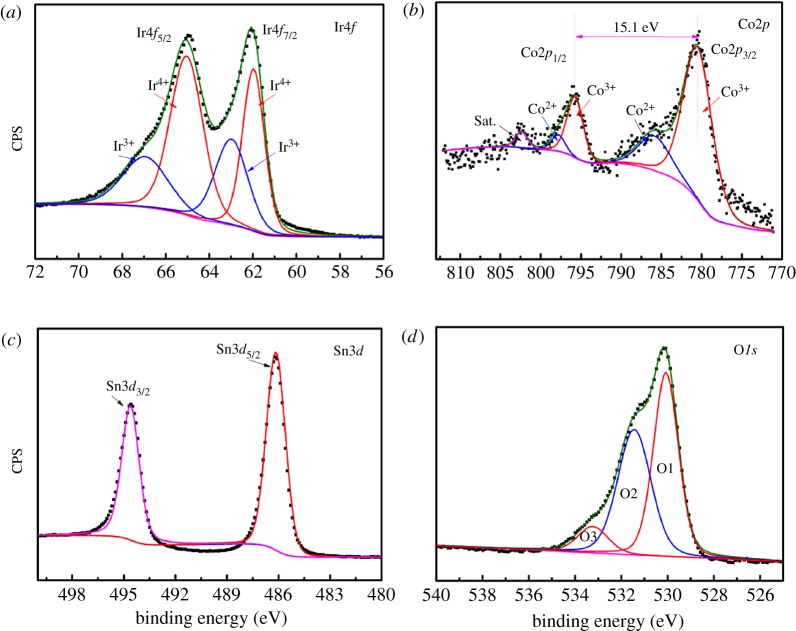
The high-resolution XPS spectrum of (a) Ir4f, (b) Co2p, (c) Sn3d and (d) O1s in 40IrO2/Co0.2Sn0.8O2.